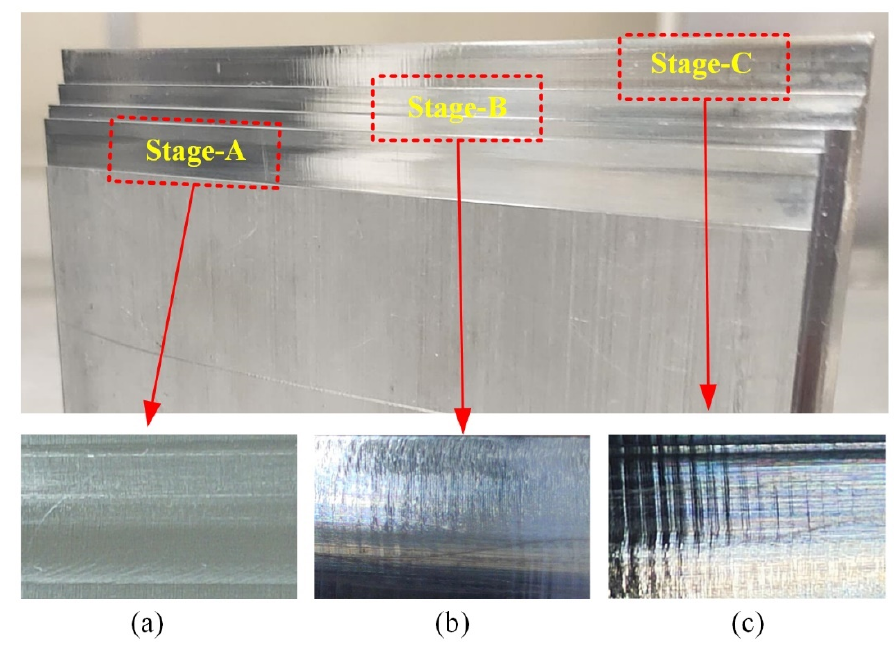
Figure 1. Surface of milling-machined workpiece. ( a ) Stable; ( b ) Unlabeled; ( c ) Chatter.